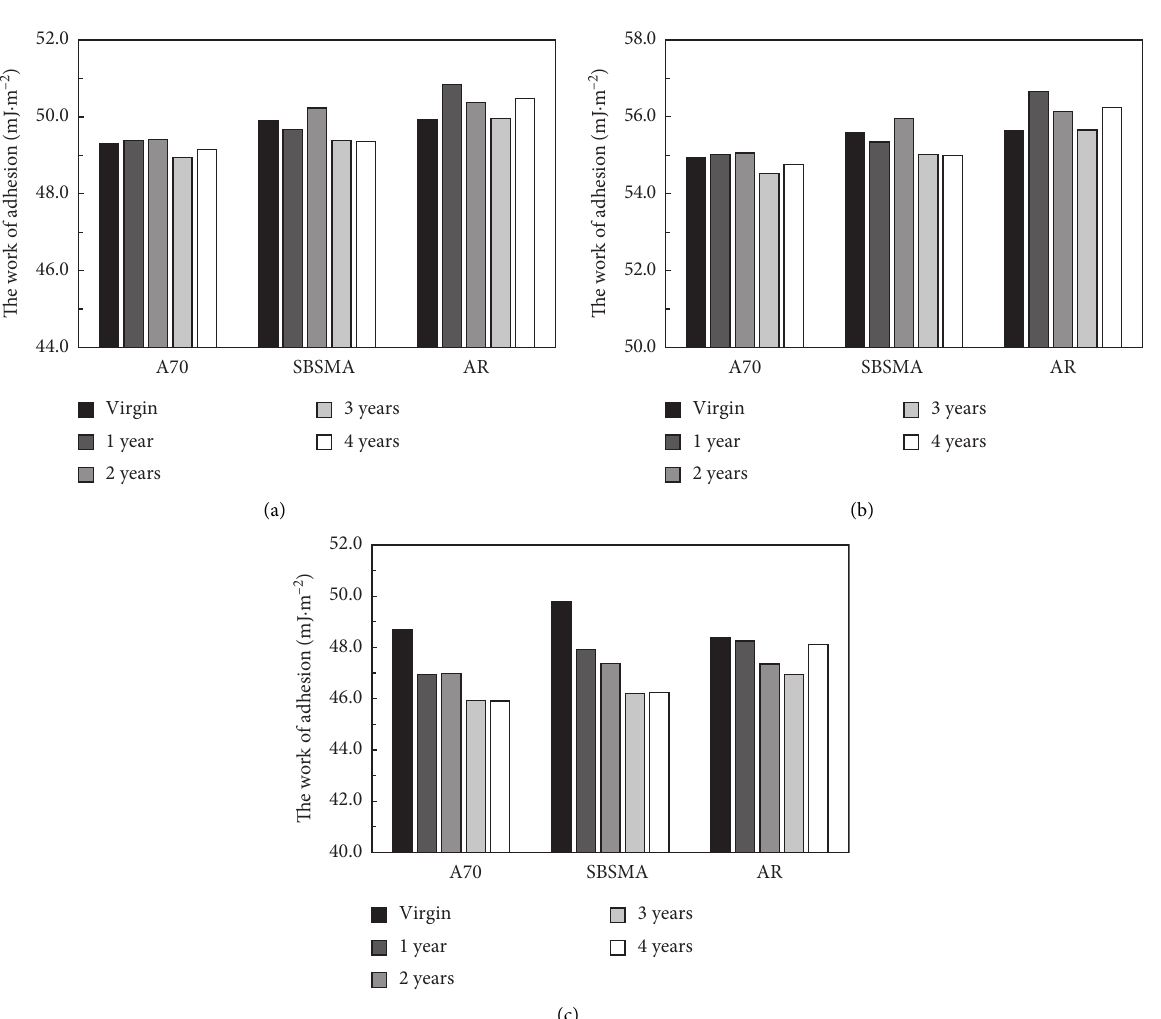
22.024.026.028.030.0